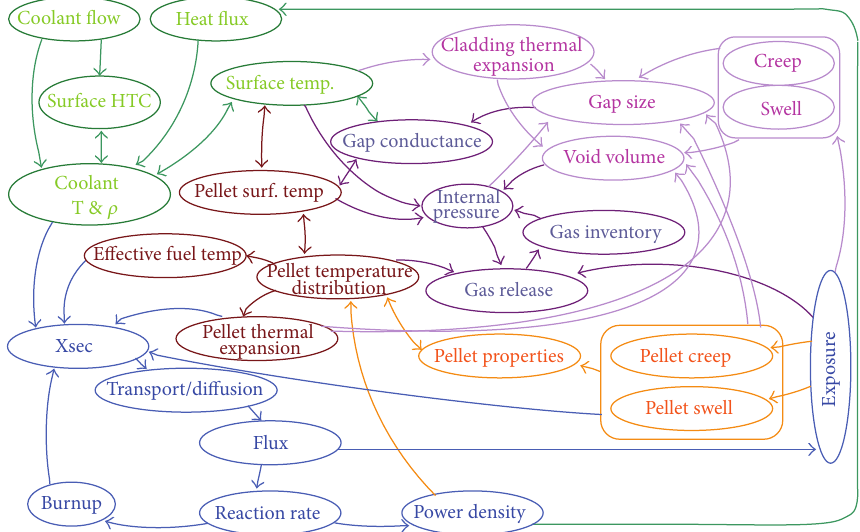
Figure 7: Multiphysics behaviors for the core with metallic